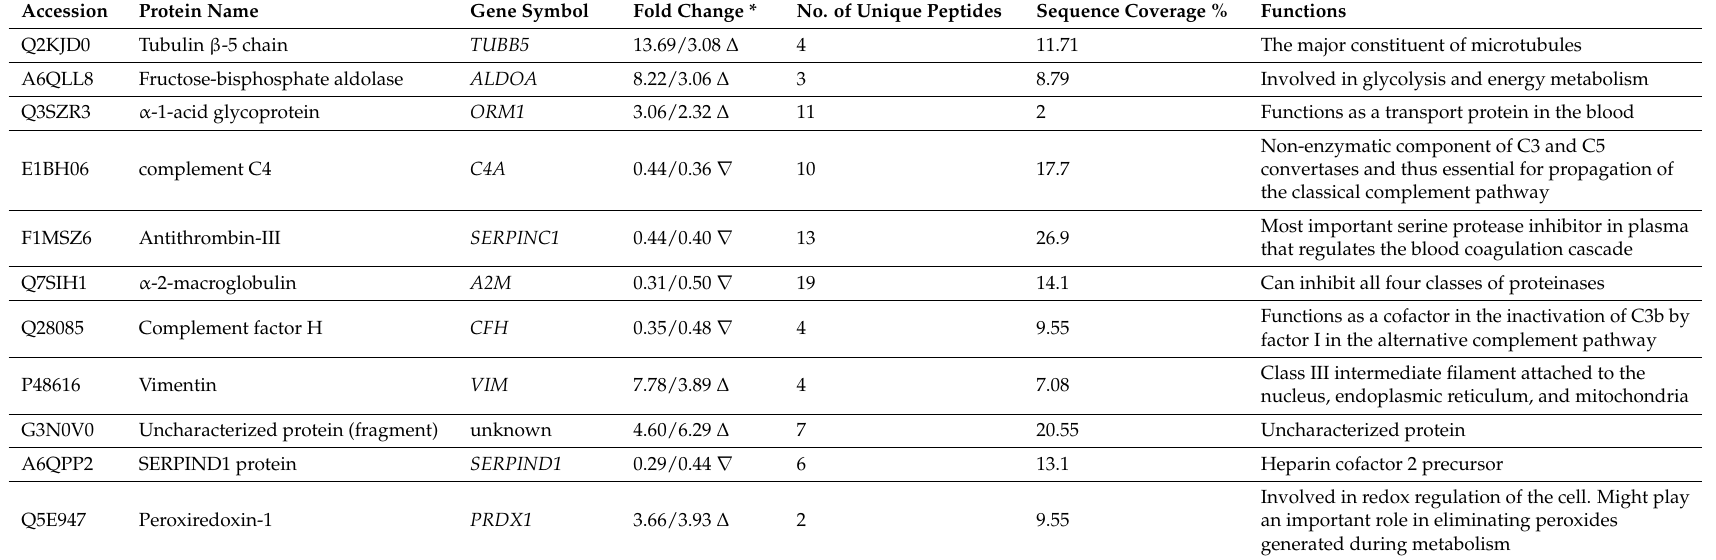
Table 3. Statistically significant differentially expressed proteins identified from large and small folliclessampled by TMT